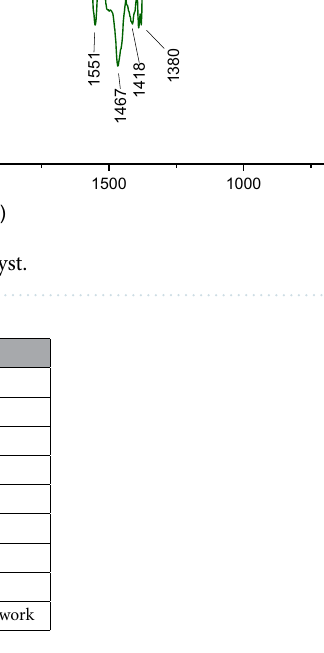
Table 3. Comparison of the polyhydroquinolines synthesis in presence of various catalysts. a Isolated yield.